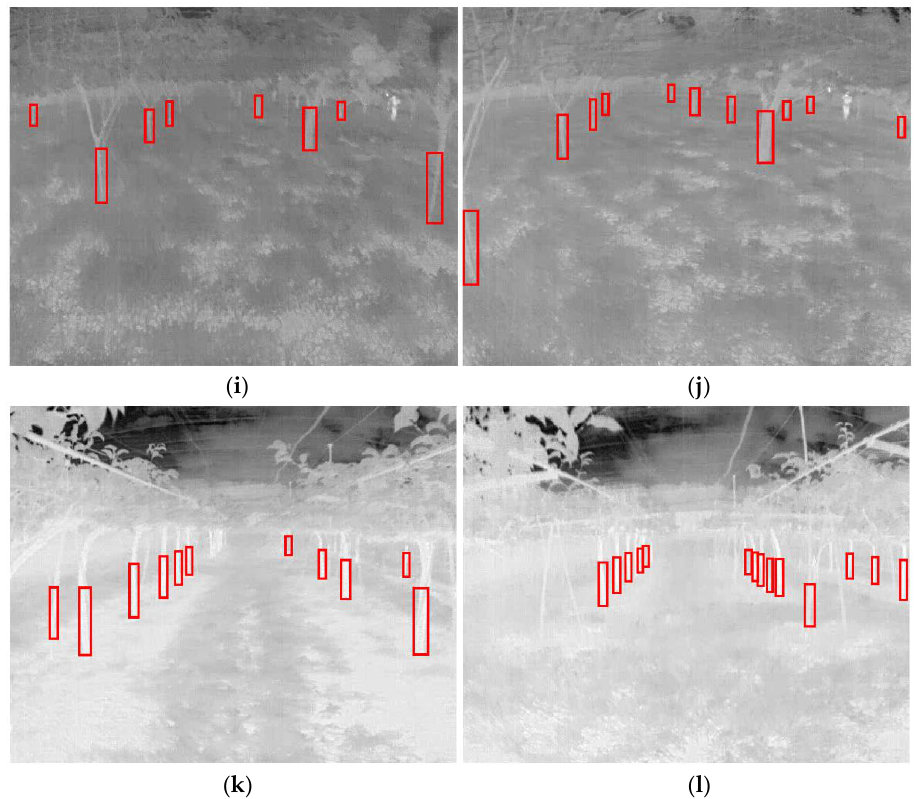
Figure 13. Image results of Faster R-CNN test: ( a – d ) no-light conditions, ( e – h ) high-light conditions, and ( i – l ) low-light conditions. Table 3. Tree trunk detection time using the deep learning model of Faster R-CNN.